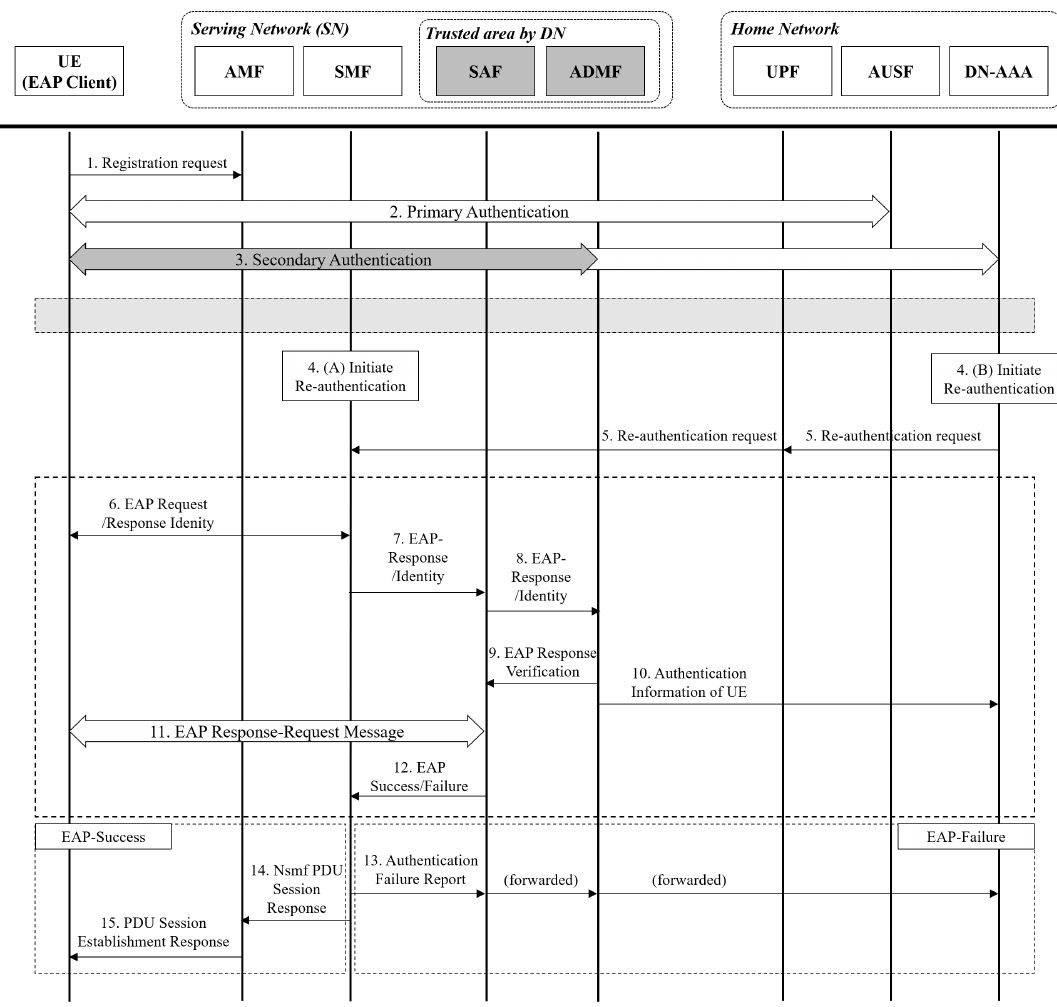
Figure 3. The Re-authentication of proposed secondary authentication